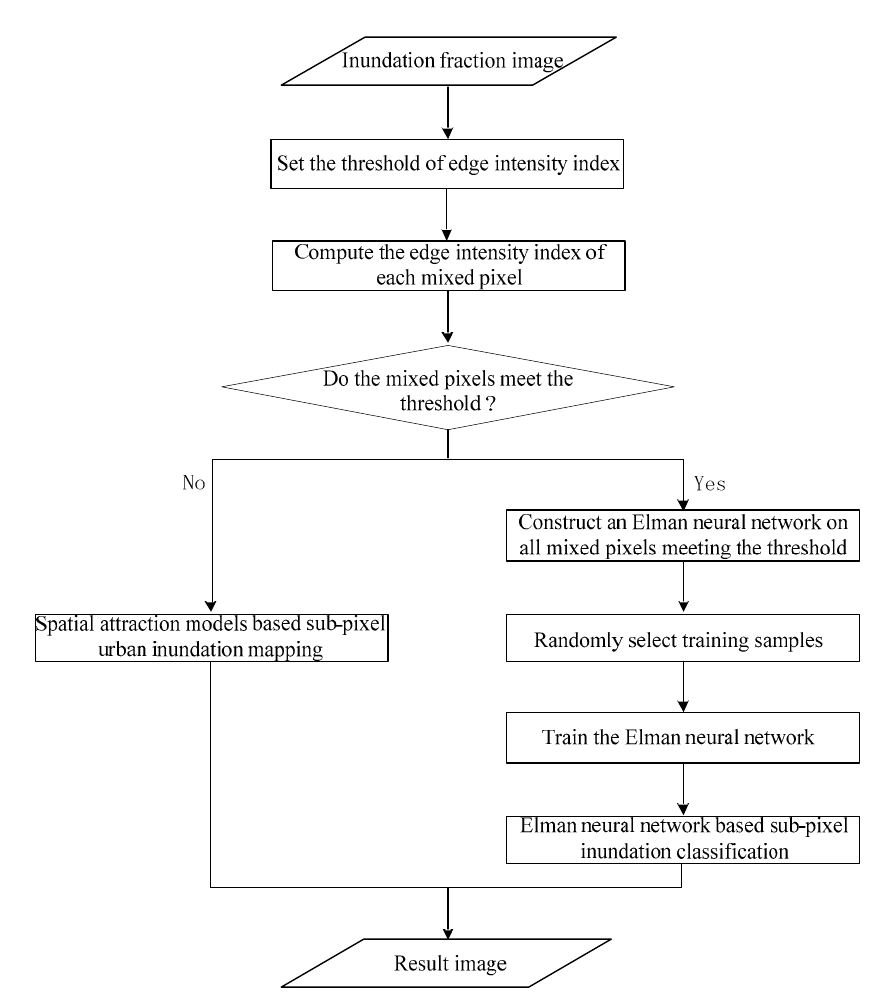
Figure 3. A flow chart of SAMENN ‐ SUIM.